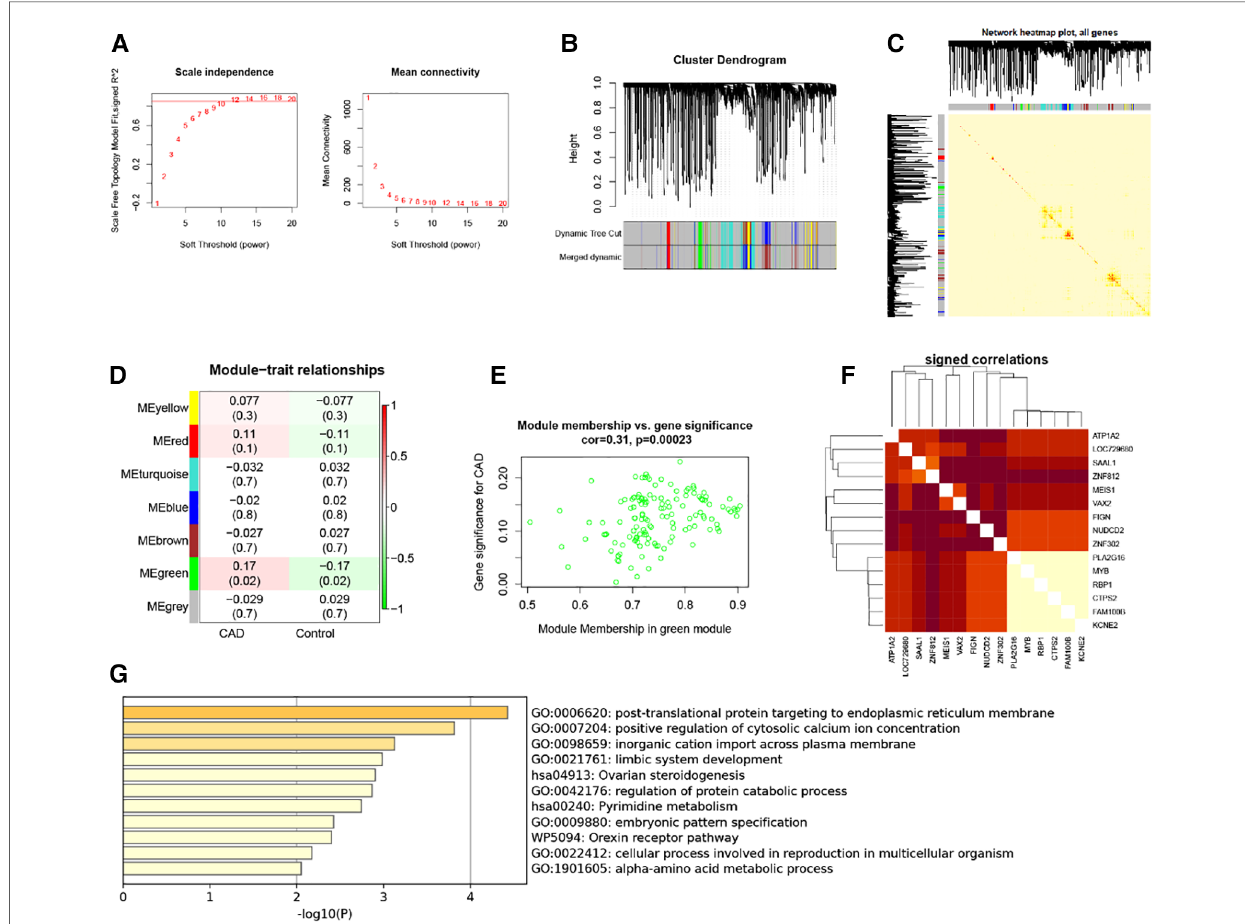
FIGURE 2 WGCNA. ( A ) 1 – 20 soft threshold power analysis using scale-free fi t index (left) and analysis of mean connectivity (right). ( B ) Gene categorization using hierarchical clustering, with various hues signifying various modules. ( C ) The heatmap of the total gene network; ( D ) Heat map showing module features associated with CAD and Control group. ( E ) Gene scatterplot in the green module. ( F ) Correlations between 15 genes. ( G ) GO and KEGG analysis in green module